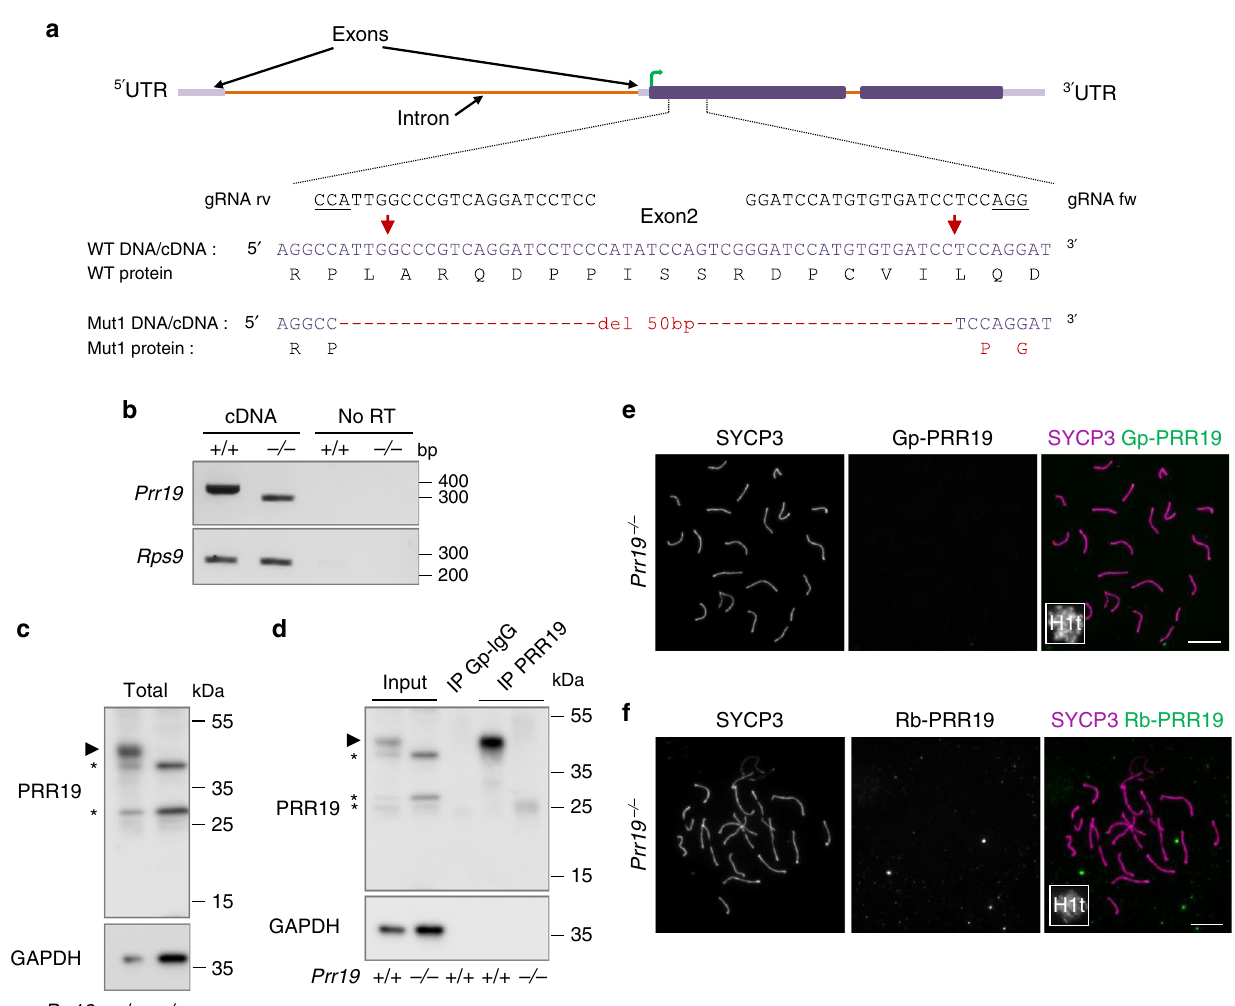
Fig. 2 The expression of PRR19 is disrupted in PRR19-de fi cient mice. a Schematics of the Prr19 locus show exons, introns, translated regions (dark lilac boxes), untranslated regions (5 ′ - and 3 ′ -UTR, light lilac boxes) and the start of open reading frame (green arrow) in exon 2. Expanded view of exon 2 shows guide RNA sequences (gRNA rv and gRNA fw with PAMs underlined) used for CRISPR/Cas9 editing, the genomic DNA/cDNA sequence of the edited region and the corresponding protein sequences in wild-type (WT) and Prr19 mutant line (Mut1). DNA break sites are marked by red arrows; red text colour marks mutated DNA and protein sequences. The same 50-bp deletion was detected in both genomic DNA and cDNA from testis. b Agarose gel pictures show RT-PCRs using primers that match (upper panel) either Prr19 exon 1 and exon 2 sites fl anking the targeted region, (lower panel) or, as a control, cDNAs of the 40S ribosomal protein S9 ( Rps9 ). The total testis RNAs of adult wild-type ( + / + ) and PRR19-de fi cient ( − / − ) mice served as templates. Samples without reverse transcriptase (no RT) show RT-PCR speci fi city. DNA length marker positions are indicated. c , d Immunoblot analysis of ( c ) total protein extracts (Total), or ( d ) anti-PRR19 immunoprecipitations from testes of adult wild-type ( + / + ) and Prr19 − / − ( − / − ) mice. d Pictures show inputs for immunoprecipitations, control immunoprecipitates with guinea pig IgG isotype antibodies (IP Gp – IgG) and immunoprecipitates with guinea pig antibodies against the C -terminal T183-Y366 peptide of PRR19 (IP PRR19). c , d Upper and lower panels show detection of proteins by guinea pig anti-PRR19 antibodies and, as loading control, anti-GAPDH antibodies, respectively. Arrowhead marks presumed band of PRR19 (40 kDa), asterisks mark unspeci fi c protein bands in upper panels. Molecular weight marker positions are indicated. e , f Immuno fl uorescence showing SYCP3, PRR19 and histone H1t (miniaturised image) in nuclear surface-spread spermatocytes of adult Prr19 − / − mice. Images show stainings with anti-PRR19 antibodies raised either in guinea pig ( e ) or rabbits ( f ). Refer to Fig. 1a and Supplementary Fig. 1d for the corresponding stainings in wild-type. Bars, 10 µ m. Source data are provided as a Source Data fi Hence, we tested if PRR19 was required for class I crossover-speci fi c crossover-speci fi c complexes, and slightly lower numbers of addi- recombination complexes, which are marked by MutL γ , CDK2 and tional weak foci in wild-type mid/late pachytene spermatocytes HEI10 in mid/late pachytene spermatocytes 3,6,15,20,21 . Whereas (Fig. 4e, f). By contrast, Prr19 − / − spermatocytes lost most strong most, if not all, chromosomes obtained one or two MutL γ foci in HEI10 foci, but contained approximately four-fold more weak wild-type, no MLH1 foci and very few if any bright MLH3 foci were HEI10 foci then wild-type (Fig. 4e, f). Thus, PRR19 is required for detected in Prr19 − / − spermatocytes (Fig. 4a, b; Supplementary the formation of mature class I crossover-speci fi c recombination Fig. 7a, b). Also, Prr19 − / − spermatocytes formed CDK2 foci only at complexes on chromosomes in the mid/late pachytene. Hence, we tested if homolog pairs are held together by telomeres, but not in interstitial crossover sites (Fig. 4c, d). The chiasmata in bivalent chromosomes in Prr19 − / − spermatocytes at HEI10 ubiquitin ligase formed ~23 bright foci, likely representing